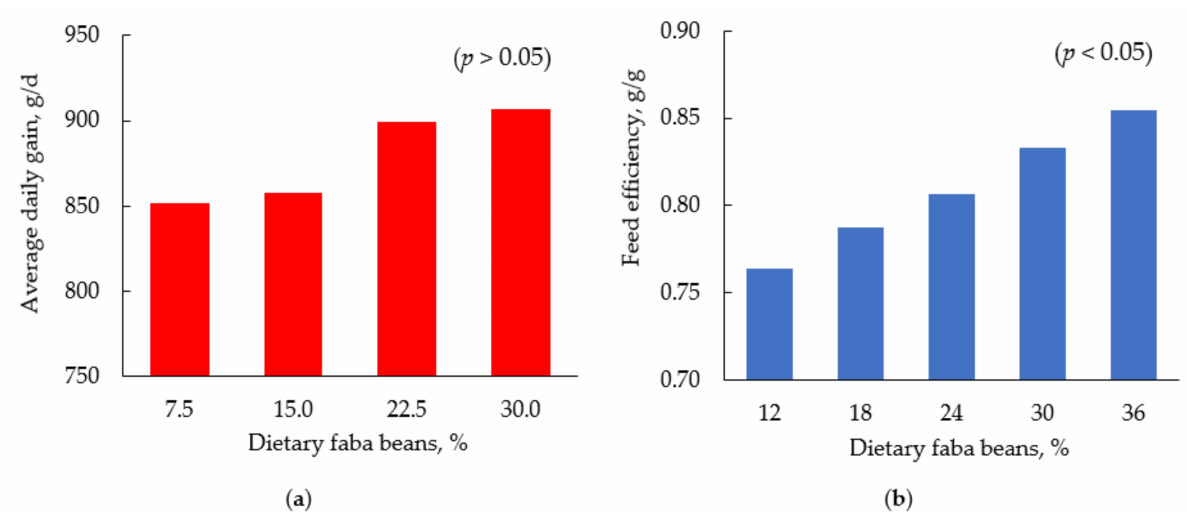
Figure 1. Growth performance of animals fed diets containing faba beans: ( a ) average daily gain (g/d) of growing pigs at 30 to 60 kg body weight [32]; ( b ) feed efficiency (g/g) of broiler chickens from 0 to 21 d post hatching